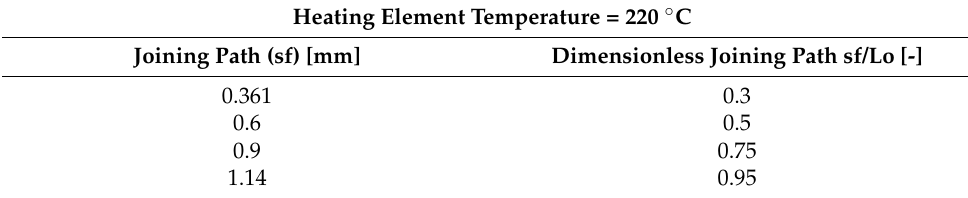
Figure 2. ( a ) Dimensions of the test sample to be welded (in mm), ( b ) sketch of joining path. Table 2. Process settings in hot plate welding.